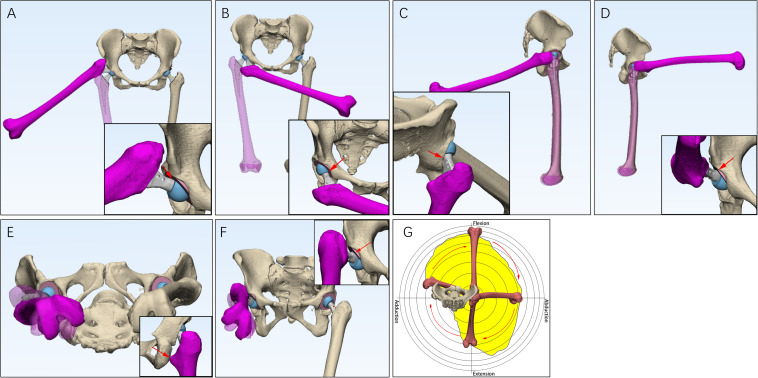
The measurement of hip ranges of motion (HROMs) and boundary map. Six parameters of HROMs were measured. The femur was rotated outward and inward in the coronal plane to test abduction (A) and adduction (B), respectively. The femur was rotated backward and forward in the sagittal plane to test extension (C) and flexion (D), respectively. The femur was rotated around inward and outward around the sagittal axis to test internal rotation (E) and external rotation (F), respectively. When measuring the boundary map, the femur was manipulated into performing circumduction (G).